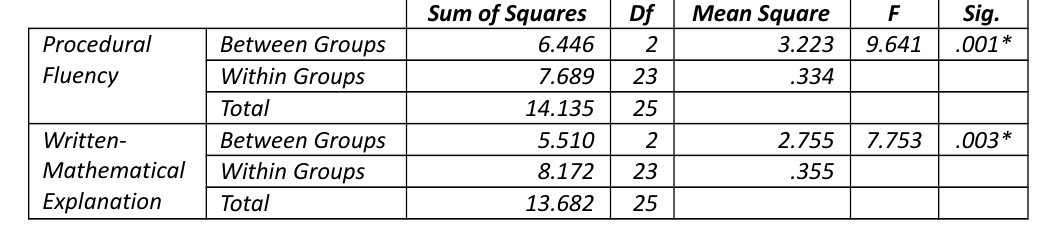
Table 3. The Difference of the Students’ Performance when grouped according to their Mathematical and English